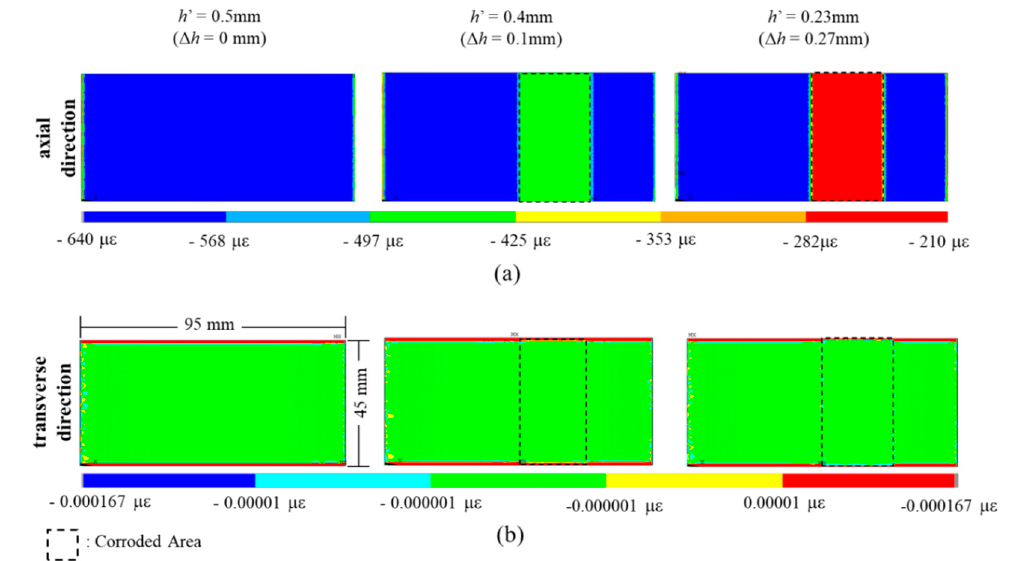
Figure 7. The side view of xy plane of FEM-simulated strain distribution on the back side of the test piece with and without a reduction in thickness, ( a ) in the axial direction, and ( b ) in the transverse direction.